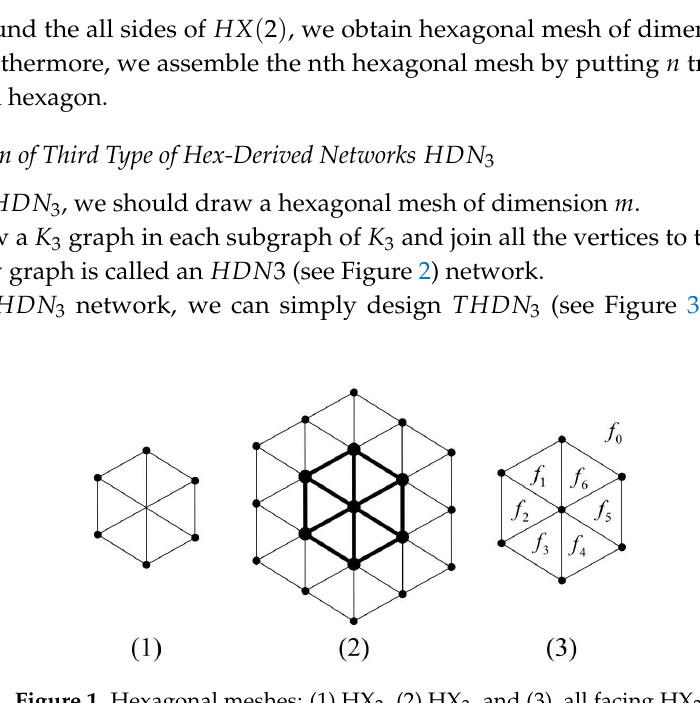
Figure 1. Hexagonal meshes: (1) HX 2 , (2) HX 3 , and (3), all facing HX 2 .